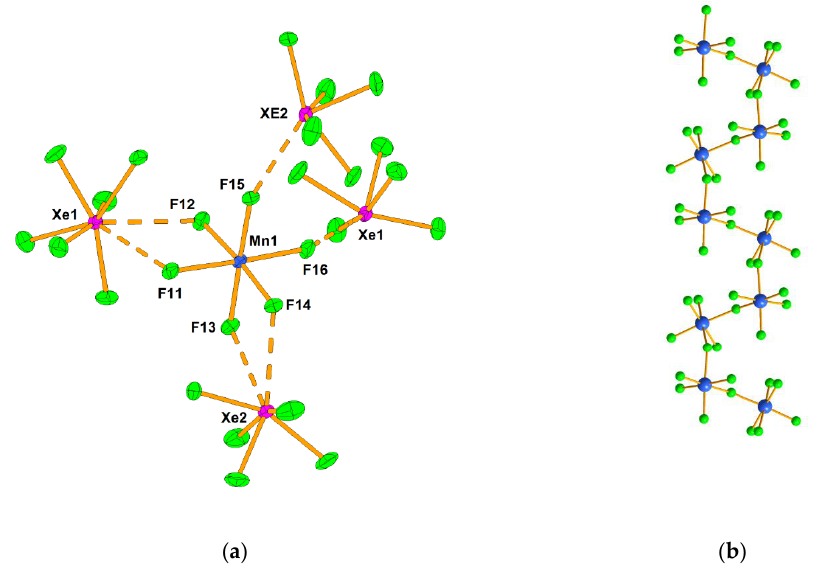
+ cations in the crystal 2 − anion and [XeF 5 ]